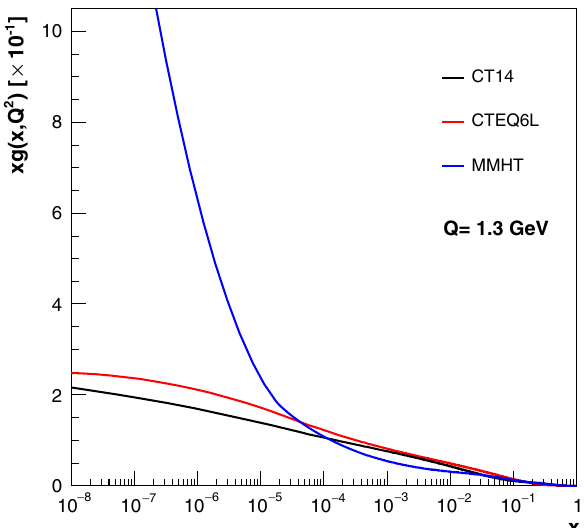
Fig. 2 The same as Fig. 1, but for the scale Q = 1 . 3 GeV Table 2 Best fit parameters of the QCD-based model with PDFs CTEQ6L [42], CT14 [41] and MMHT [43]. Quality fit estimators,